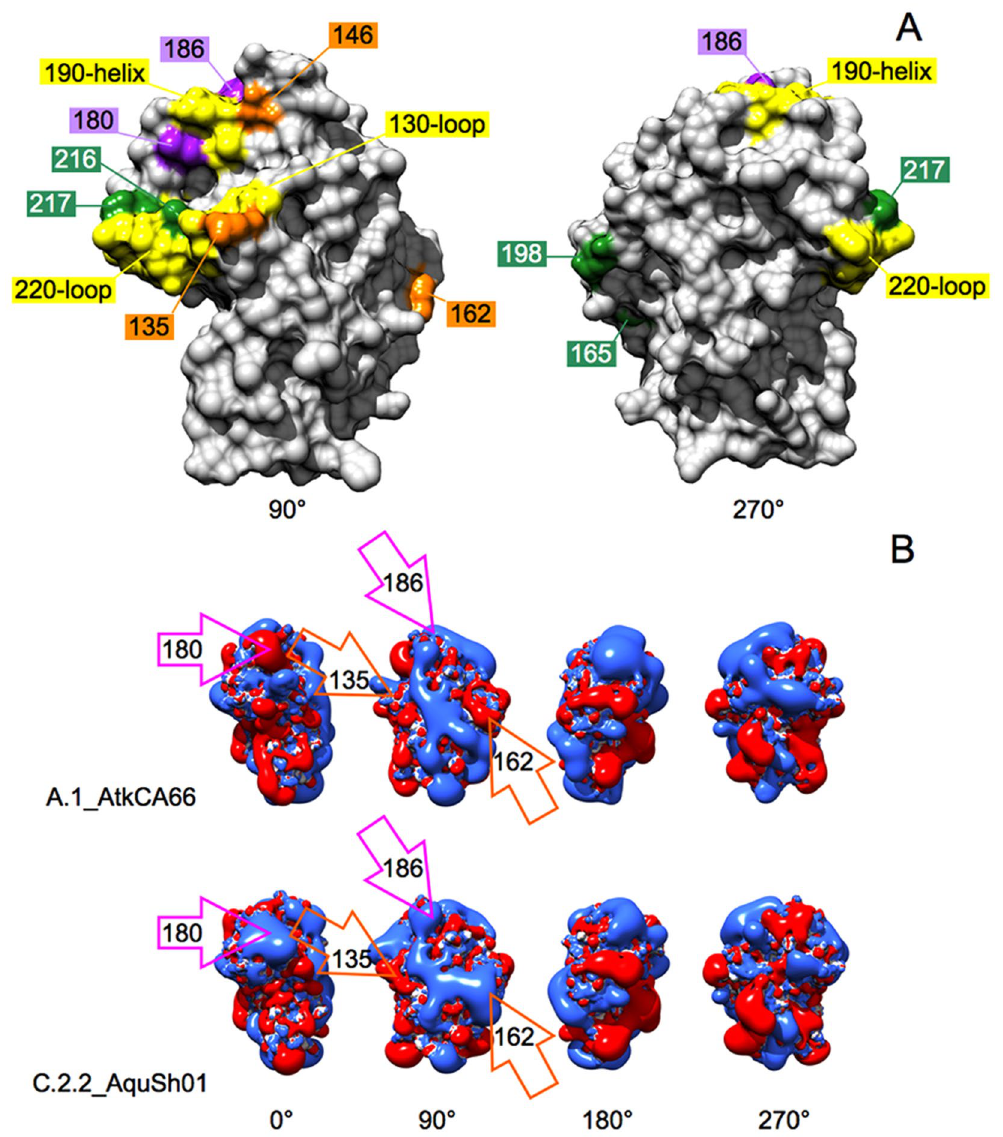
Figure 3. Upper panel: 90° and 270° views of the RBD sub-region of H9N2 HA highlighting relevant surface epitopes. Lower panel: four-step 90° views of representative H9N2 RBDs highlighting ED mediated by mutation of specific